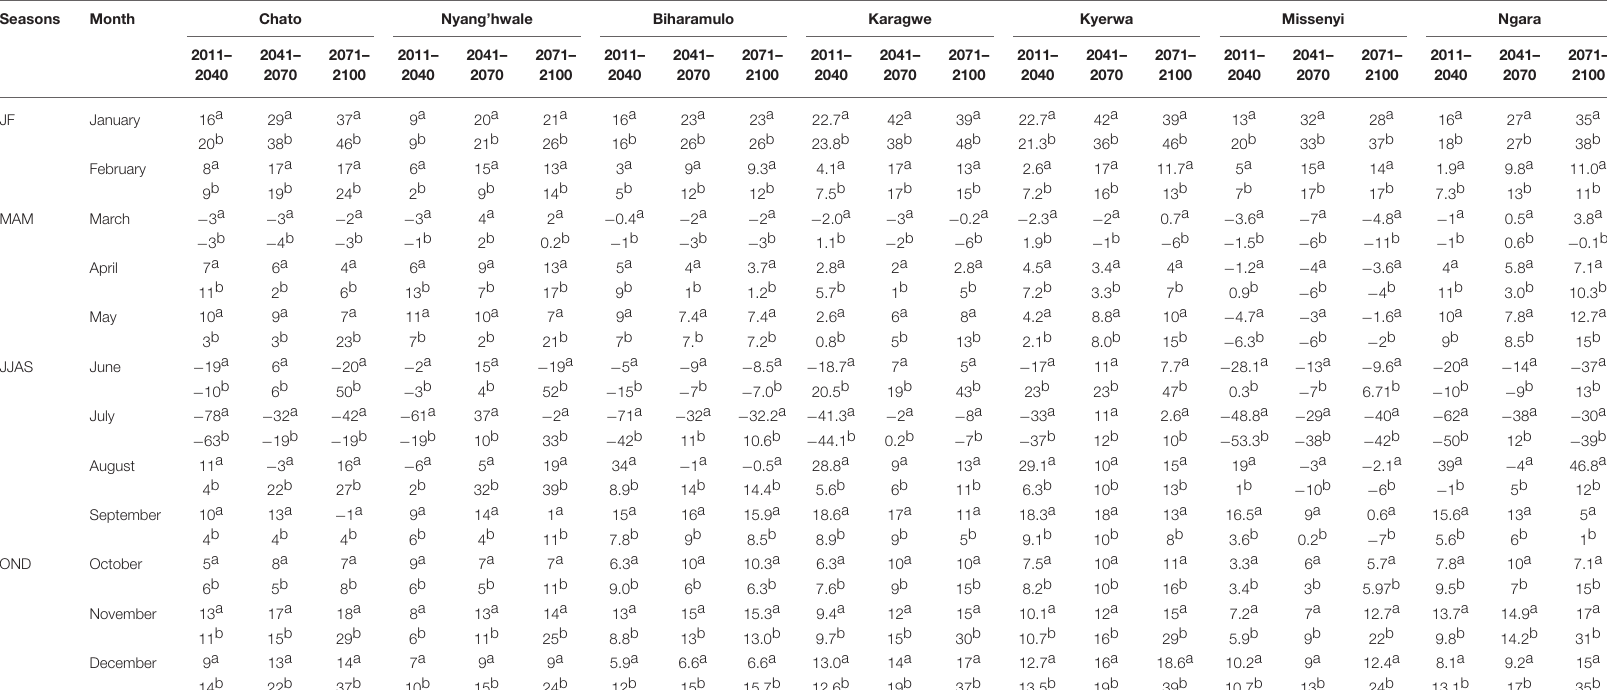
TABLE 8 | Projected percentage changes in rainfall (%) in the Kagera and Geita regions during the present (2011–2040), mid (2041–2070), and end (2071–2100) century for Representative Concentration Pathway a (RCP) 4.5 scenario and b RCP 8.5 scenario. Seasons Month